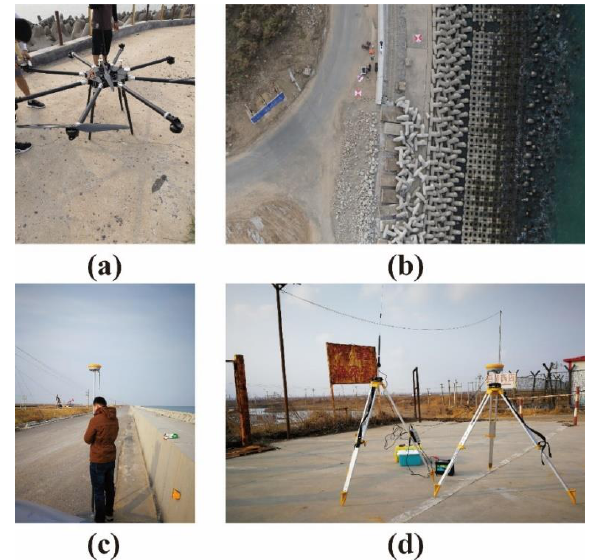
Figure 5. ( a ) DJI Matrice 600 Pro UAV, vehicle of Light Detection and Ranging (LiDAR); ( b ) control point arrangement; ( c ) detail points collection; ( d ) reference station for the Global Navigation Satellite System (GNSS) real time kinematic (RTK).